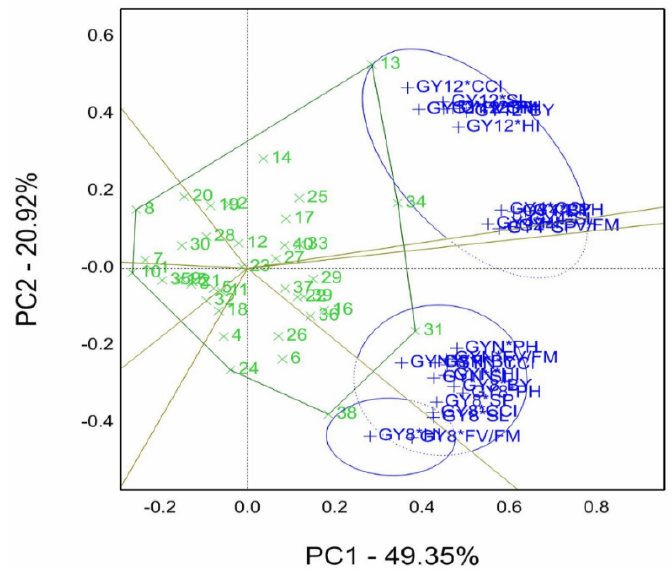
Figure 4. Which − won − where biplot of forty wheat genotypes grain yield gm per pot (GY) grown under 0.4, 4.0, 8.0, and 12.0 dS/m diluted seawater evaluated in pot experiments in the 2019/20 season.